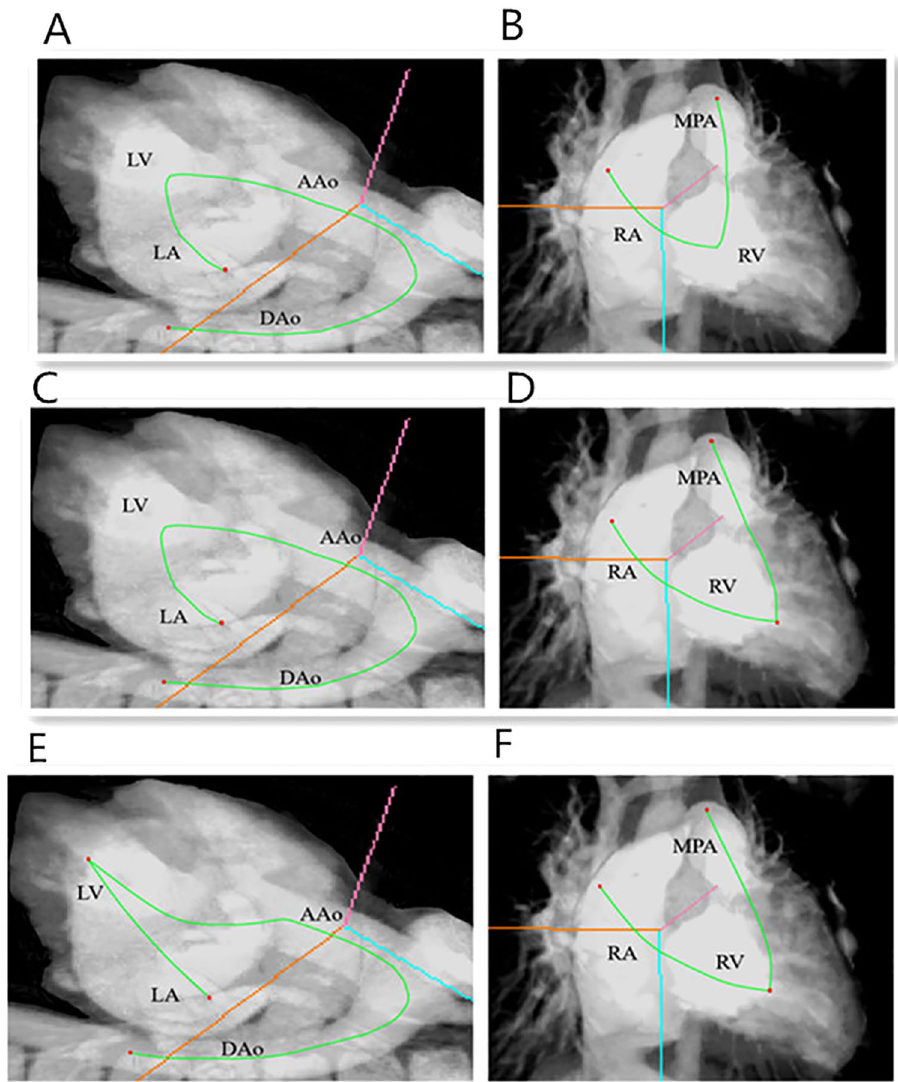
Figure 1. An example of roaming paths plan for left and right heart system in 3D image. Figure A and B showed the path planned under VE- automatic mode, Figure A showed left heart system automatic path and Figure B showed right heart system automatic path (green line), two-end seeds (red points) were placed at top of left atrium, midpoint in descending aorta, top of the right atrium and midpoint in the main pulmonary artery. Figure C and D showed the path planned under VE-combined mode, Figure C showed left heart automatic path and Figure D showed right heart manual path (green line). Figure E and F showed the path planned under VE-manual mode, Figure E showed left heart manual path and Figure F showed right heart manual path (green line), two-end seeds (red points) were placed manually at top point in left atrium, apex point in left ventricle, midpoint in descending aorta, top point in right atrium, apex point in right ventricle and midpoint in the main pulmonary artery, respectively. LA: left atrium; LV: left ventricle; AAo: ascending aorta; DAo: descending aorta; RA: right atrium; RV: right ventricle; MPA: the main pulmonary